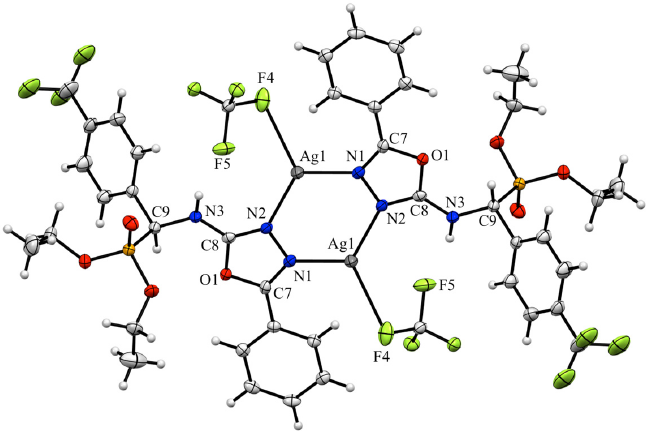
Figure 3. ORTEP drawing of complex 2 , 50 % probability thermal ellipsoids. Important bond lengths (Å) and angles (°): Ag1 ‐ N1 2.260(2), Ag1 ‐ N2 2.215(2), Ag1 ‐ F4 2.652(2), N1 ‐ N2 1.406(3), N2 ‐ C8 1.311(4), C8 ‐ O1 1.353(3), O1 ‐ C7 1.372(3), C7 ‐ N1 1.293(4), N1 ‐ Ag1 ‐ F4 112.85(8), F4 ‐ Ag1 ‐ N2 123.02(7), N2 ‐ Ag1 ‐ N1 123.75(8), C7 ‐ N1 ‐ N2 107.4(2), N1 ‐ N2 ‐ C8 105.4(2), N2 ‐ C8 ‐ O1 112.3(2),